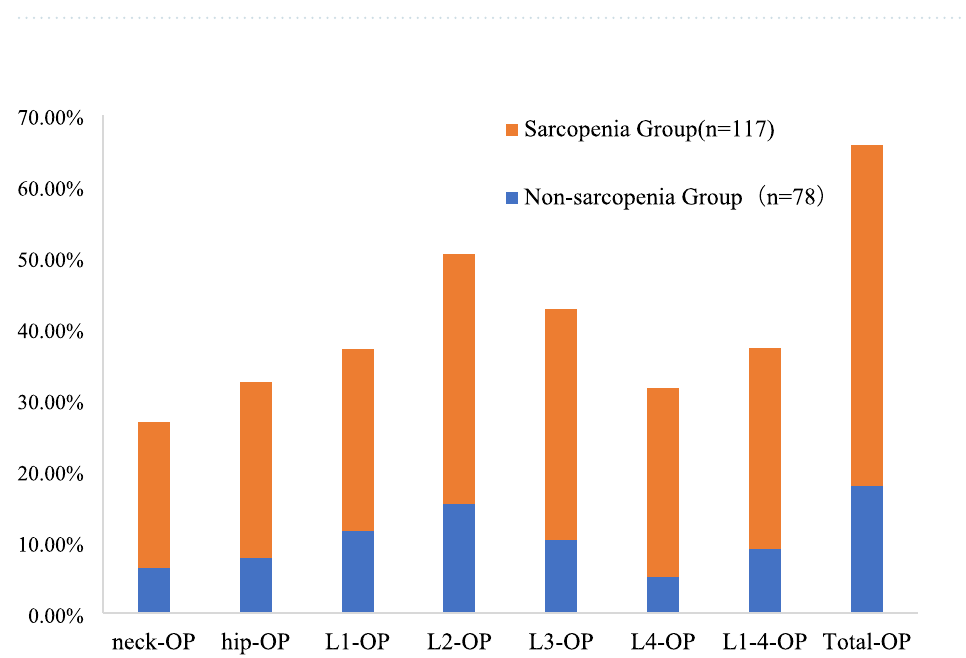
Figure 3. Comparison of OP between female RA patients with sarcopenia or